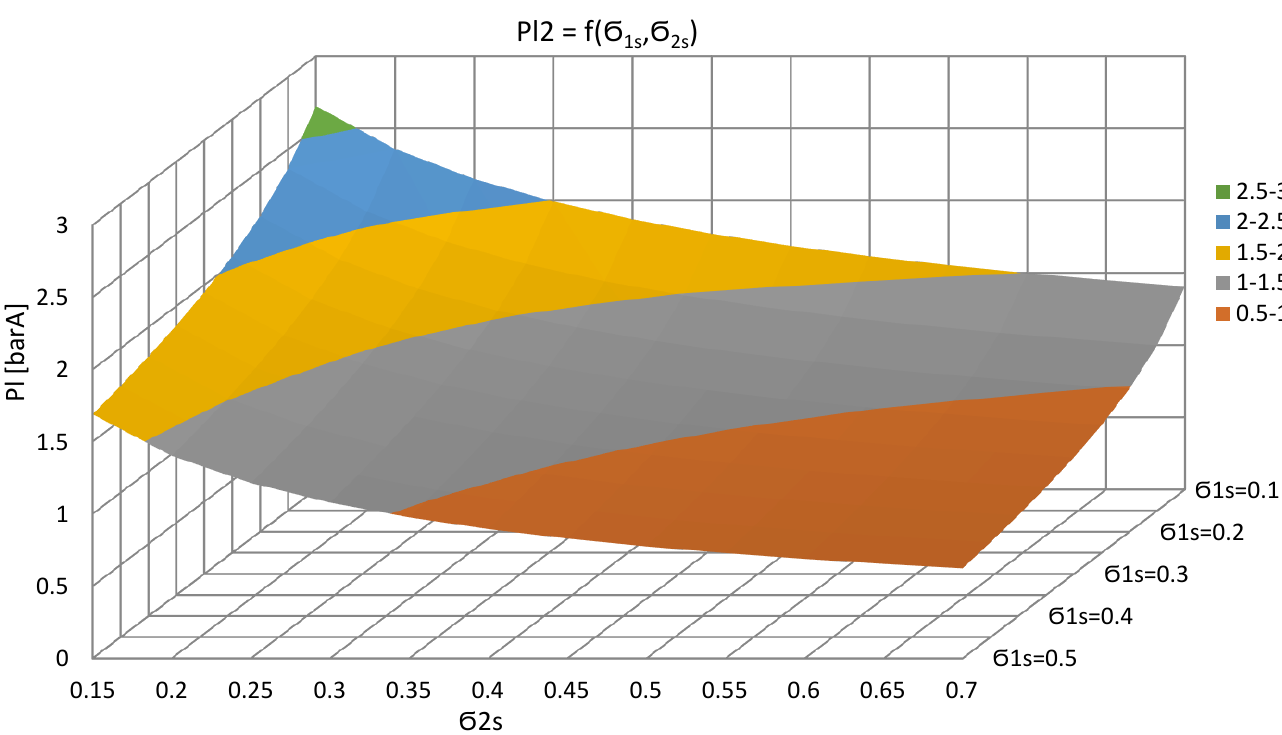
Figure 4. Relation of the steam pressure on the outlet from the two-stage injector unit driven by steam bleads 3.0 and 6.6 barA in the function of the ejection ratio P l 2 = f ( σ 1 s , σ 2 s ) .